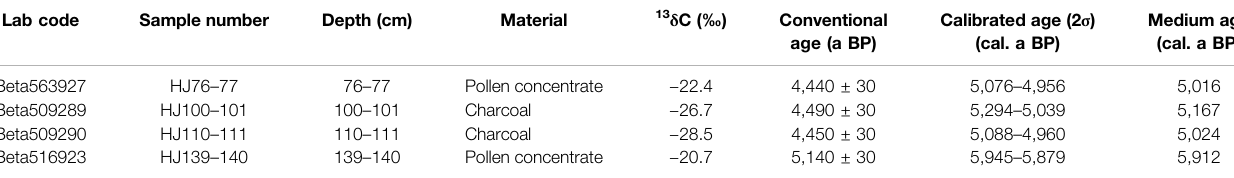
TABLE 1 | AMS 14 C dating results of the unit T0103 of the Hejia Site. Lab